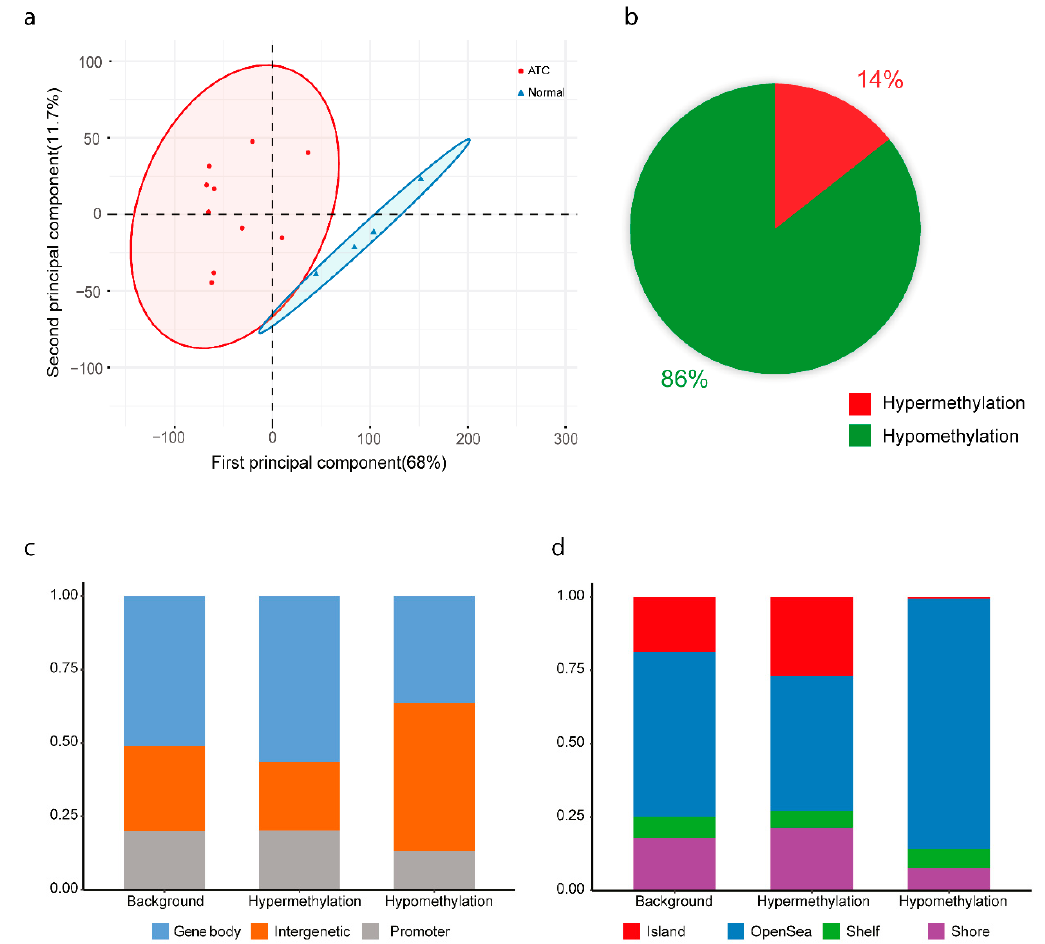
Figure 2. Methylation analysis of anaplastic thyroid cancer (ATC). ( a ) Unsupervised clustering by principal component analysis of methylation data from ten ATC cases and tissue from four normal thyroids. ( b ) Proportions of hypomethylated and hypermethylated differentially methylated probes in ATC. ( c ) Classification of probes based on their location relative to promoter, body and intergenic region based on Illumina EPIC annotation. ( d ) Classification of probes based on location relative to CPG island, shore, shelf, and open sea regions based on Illumina EPIC annotation. Background refers to all the probes in the